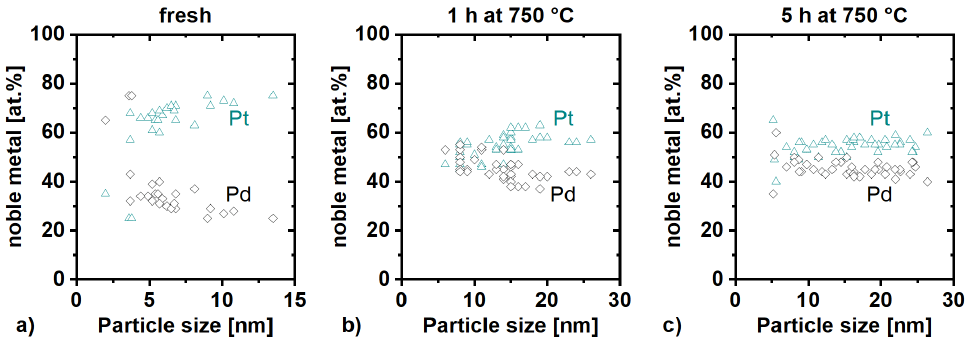
Figure 3. Noble metal distribution of bimetallic Pt-Pd particles in the fresh state ( a ), after aging for 1 h at 750 °C ( b ) and after aging for 5 h at 750 °C ( c ).